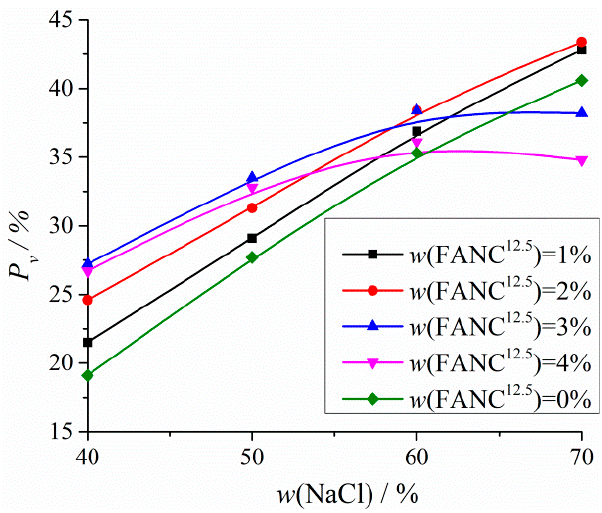
Figure 3. The P v values of porous UHMWPE/FANC 12.5 specimens.